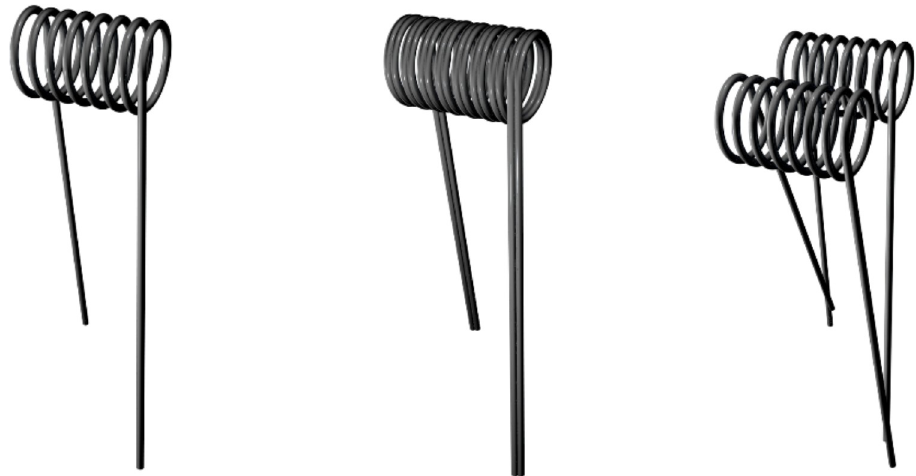
Fig 2. Illustration of single (left), parallel (middle) and dual coils (right). The parallel and dual coil contains two identical wires; however, the dual coils are wrapped individually with respective wicks. Each style can be oriented vertically or